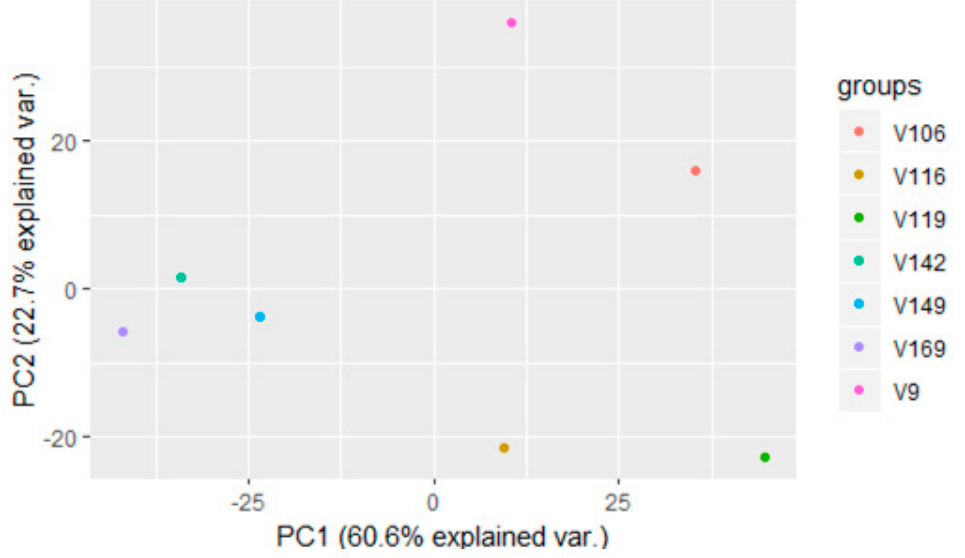
Figure 3. Principal component analysis (PCA) of mean values for the 1900 absorbance values of FT-NIR spectra for the seven maturity levels of “Victoria” grape: 16.9 ◦ (V106), 14.9 ◦ (V149), 14.2 ◦ (V142), 11.9 ◦ (V119), 11.6 ◦ (V116), 10.6 ◦ (V106), and 9 ◦ (V9)